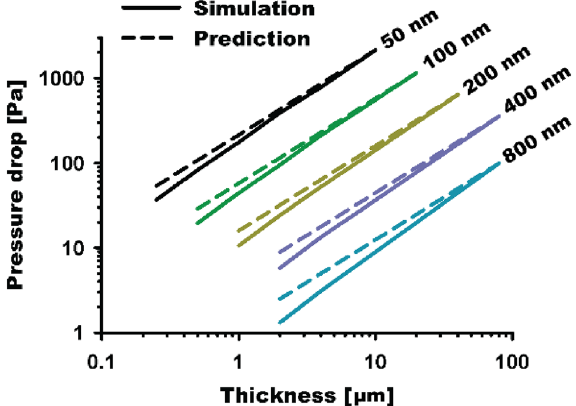
Figure 7. Relationship between filter thickness and pressure drop on nanofiber filters with the fiber sizes of 50, 100, 200, 400, and 800